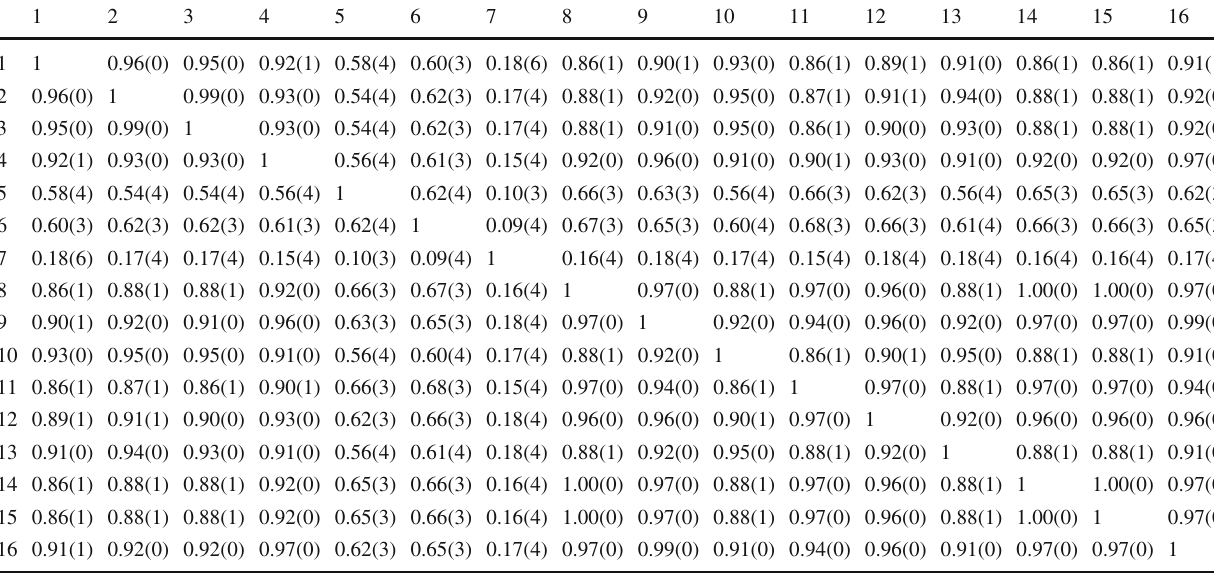
Table 4 Main comparison of selected definitions of the topological charge. The numbers correspond to the numbering given in Fig. 9. We give the correlation coefficient between different definitions and its error (0 means that the error is smaller than